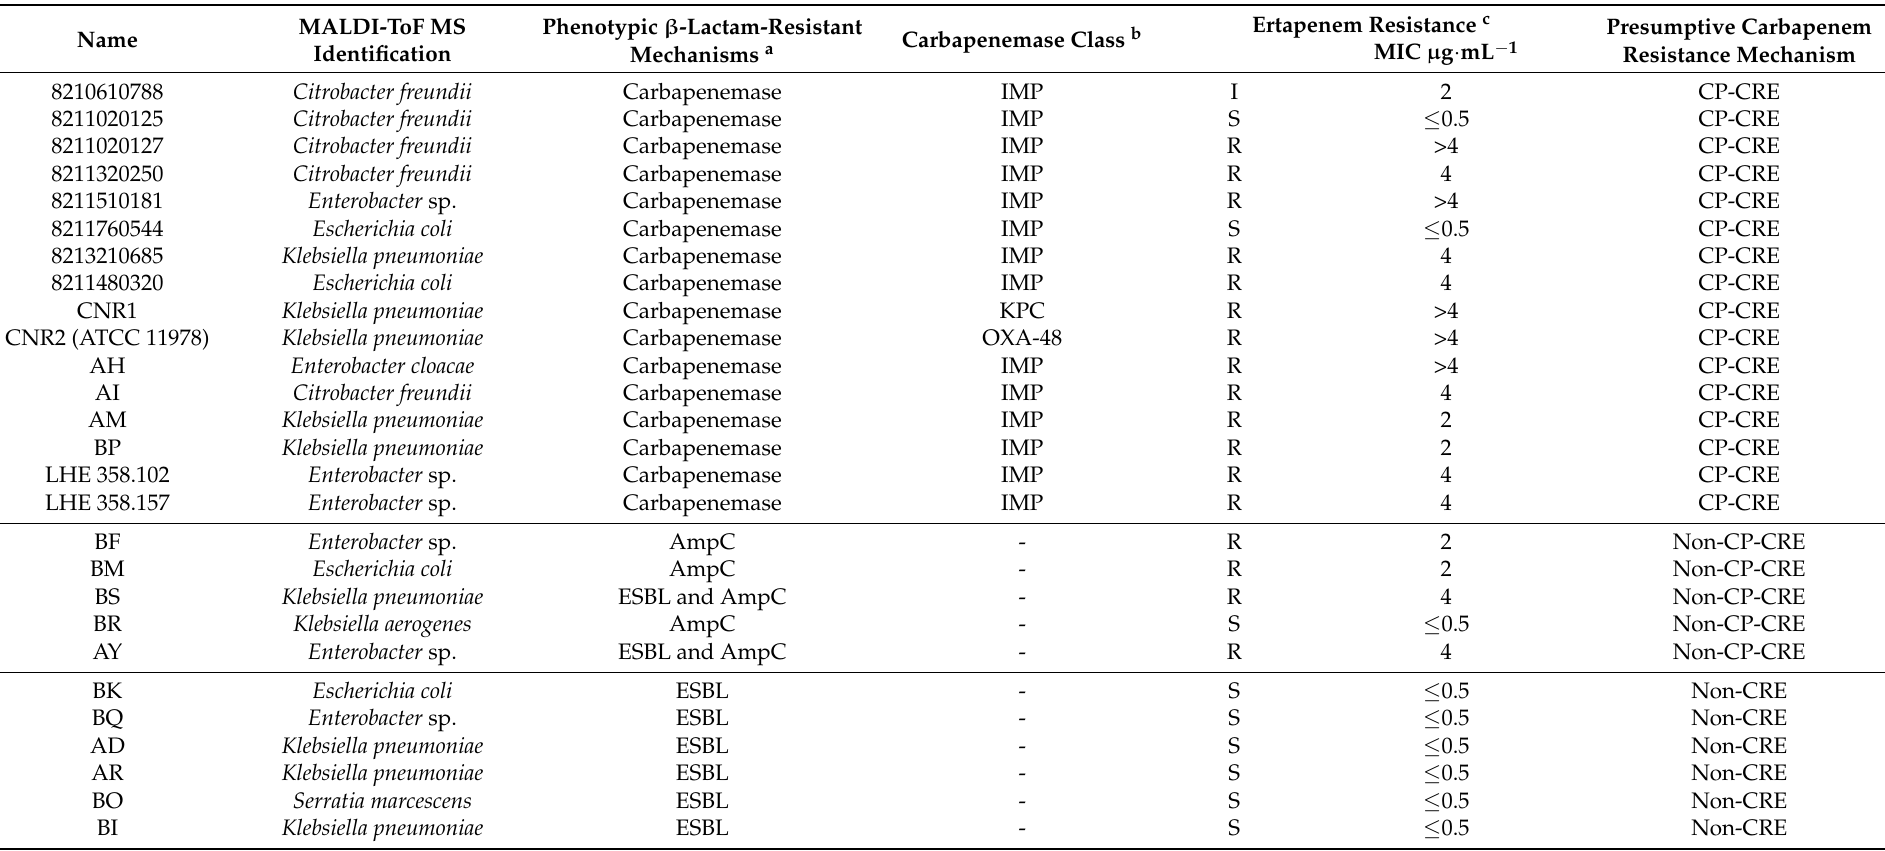
Table 1. Characteristics of β -lactam-resistant Enterobacterales used as controls in this